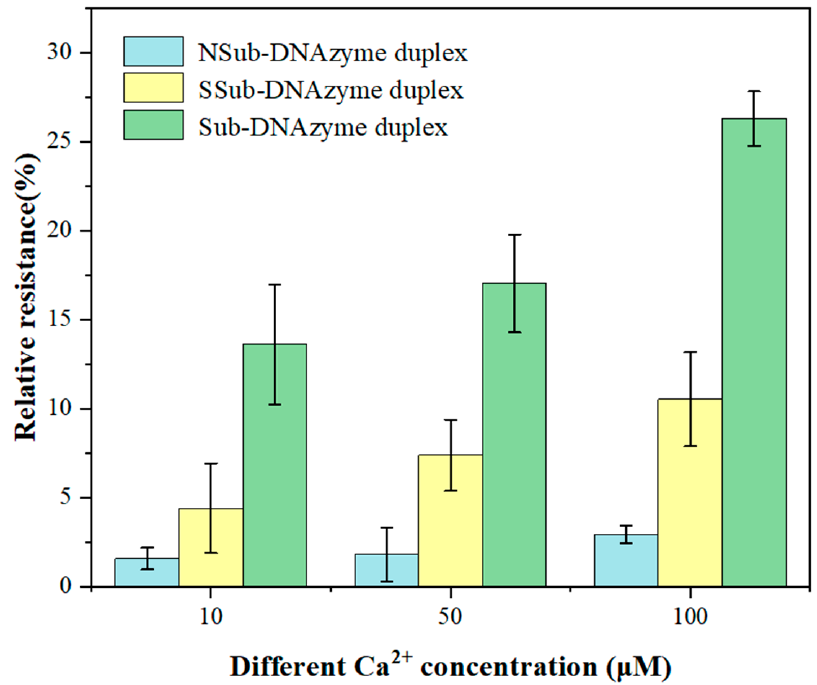
Figure 7. The relative resistance of Sub-DNAzyme duplex structure and length to different Ca 2+ concentration (The error bars were determined in three duplicates).